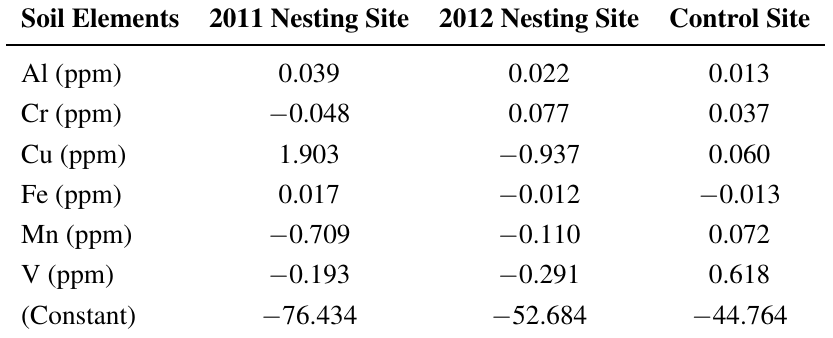
Table 4. Classification Function Coefficients (using Fisher’s linear function) for the Discriminant analysis for all significant soil elements used to assess the three sites (2011 Nest, 2012 Nest and control Site) used by Socotra Cormorants in the